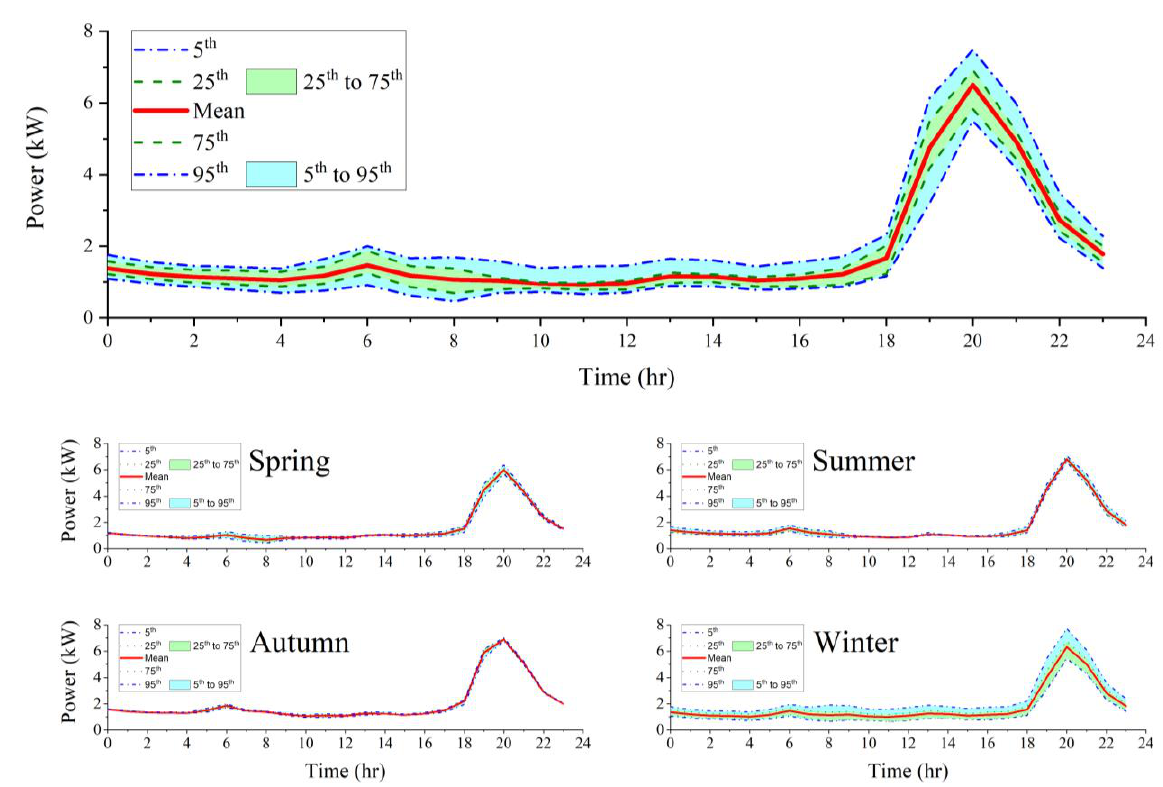
Energies 2023 , 16 , x FOR PEER REVIEW 20 of 36 Figure 17. Average annual and seasonal residential daily load profiles (with percentile ranges).